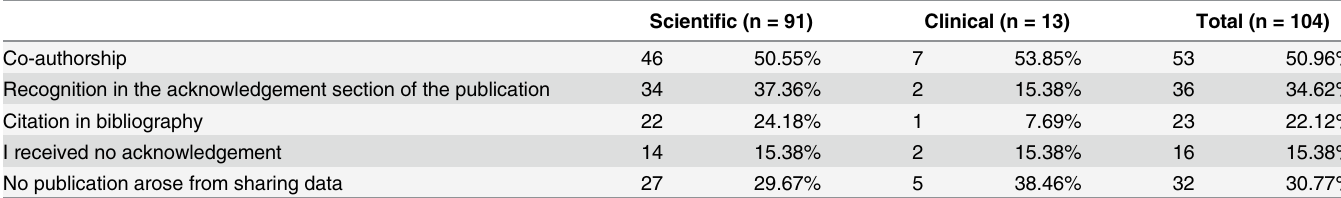
Table 14. Responses to “ If another researcher published or presented on results from your shared data, how were you acknowledged? ”